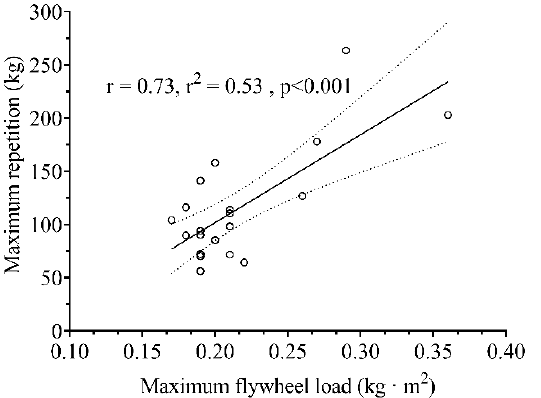
Figure 4. Association between maximum repetition (ISO-load) and the maximum flywheel load (FW-load). Dotted lines represent 95% of the confidence intervals.